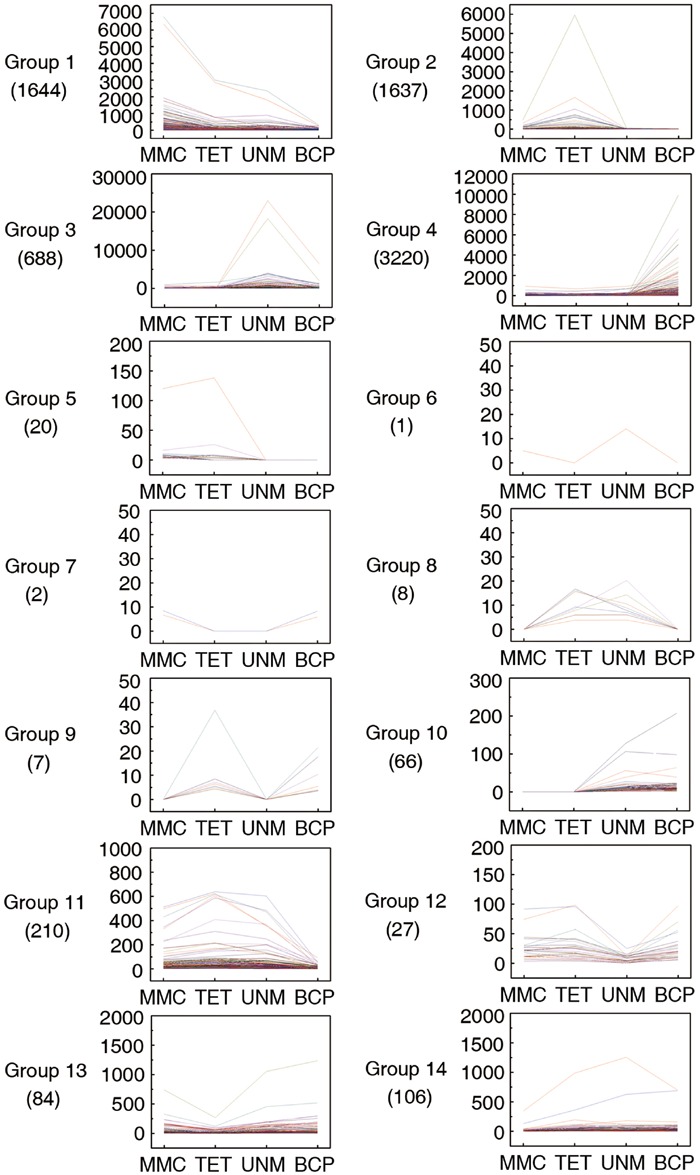
Pairwise comparisons within four DGE libraries. Genes with similar expression patterns were grouped together to make 14 groups. The line graphs show the variation of expression levels at four stages of anther development.